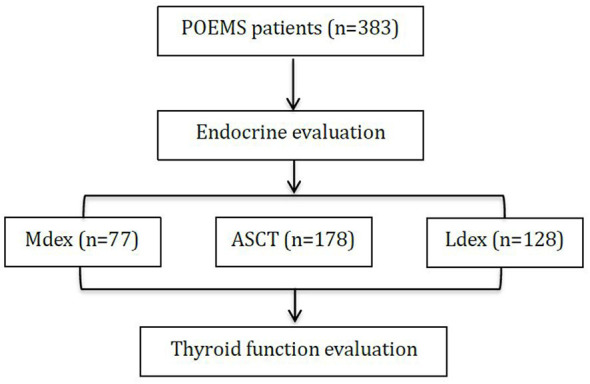
The flowchart of the study. Combination therapy of melphalan and dexamethasone regimen (MDex), autologous peripheral stem cell transplantation (ASCT), and low-dose lenalidomide plus dexamethasone regimen (LDex).